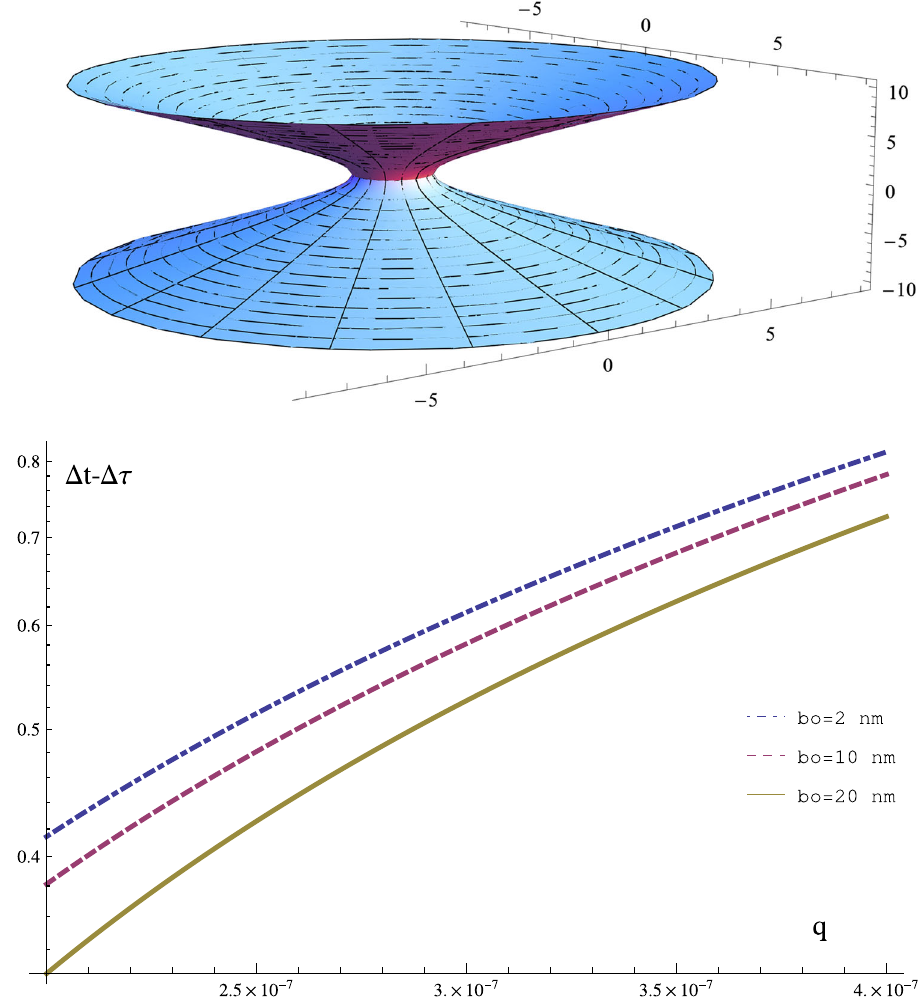
Fig. 1 3-D plot of a Casimir wormhole on a graphene sheet. Distances given in nm, with r